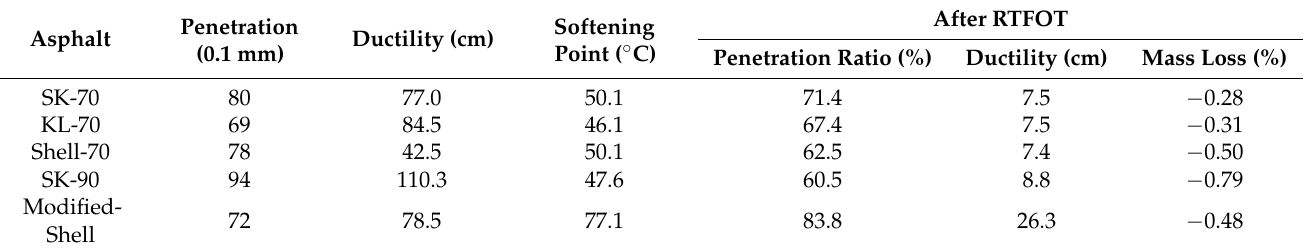
Table 1. Performance Index of